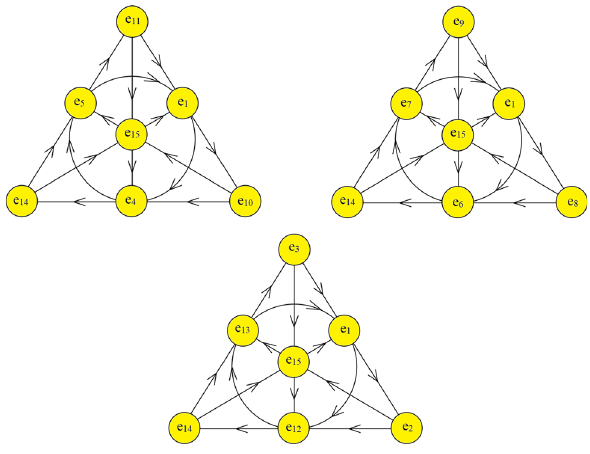
Fig. 2 Fano planes of three octonionic subalgebras in the